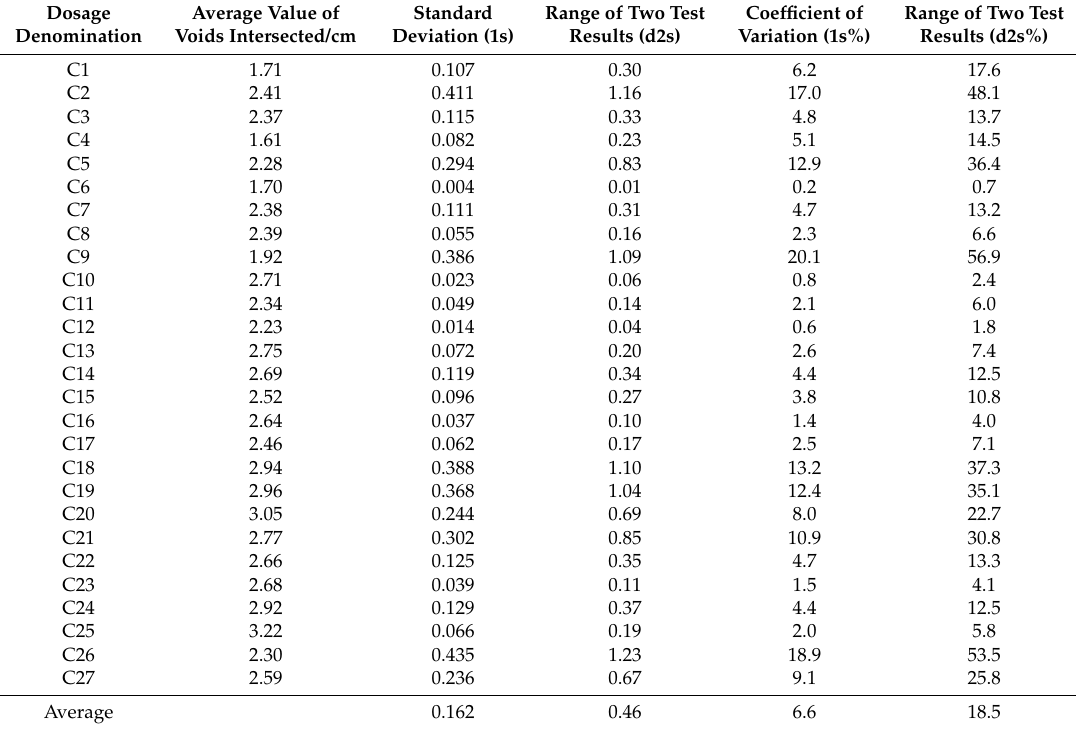
Table A2. Average value and dispersion data of the voids intersected /cm of the 27 dosages (two slabs per dosage).